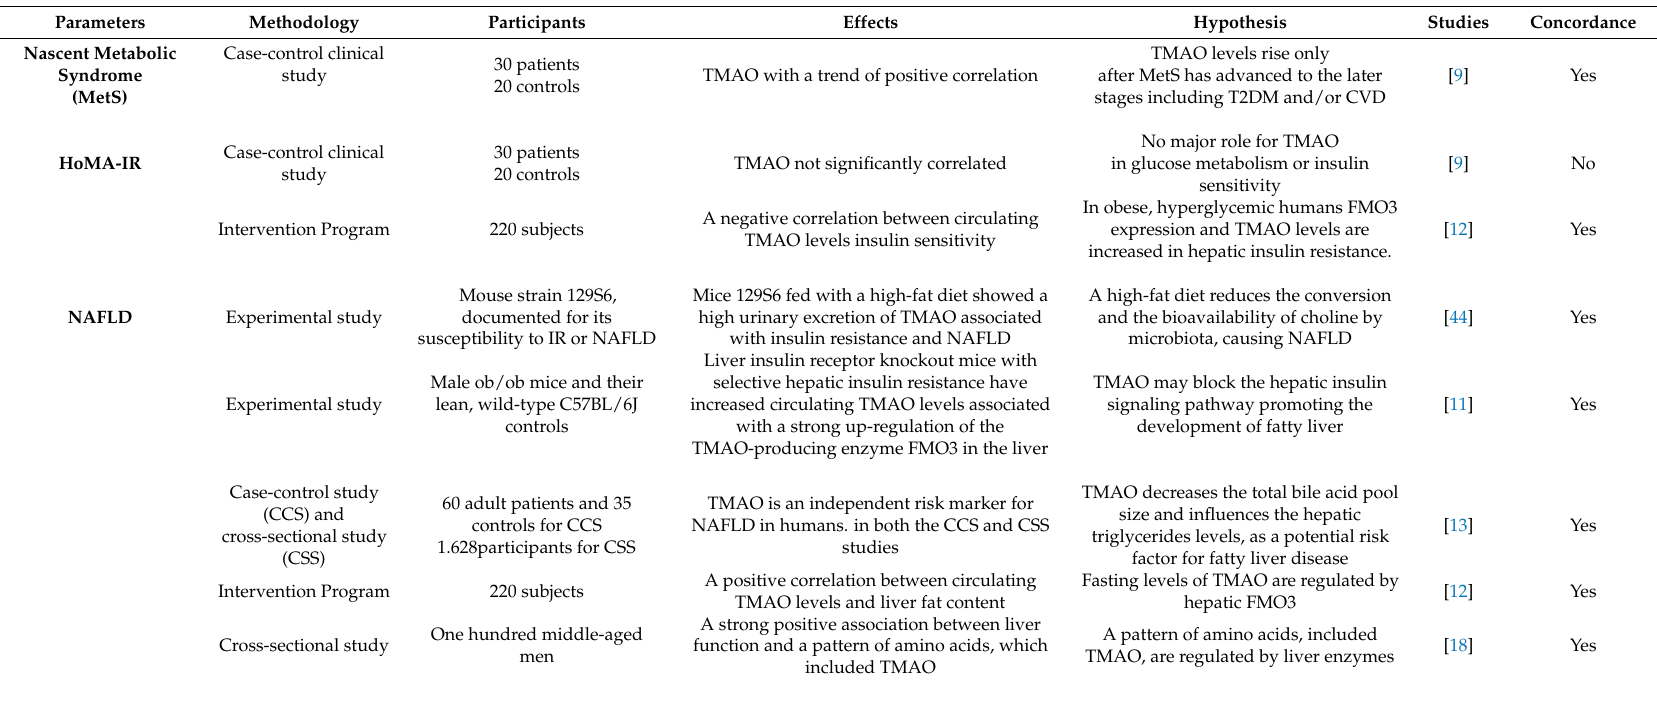
Table 6. A summary table with the main results of our study compared to the results of the general